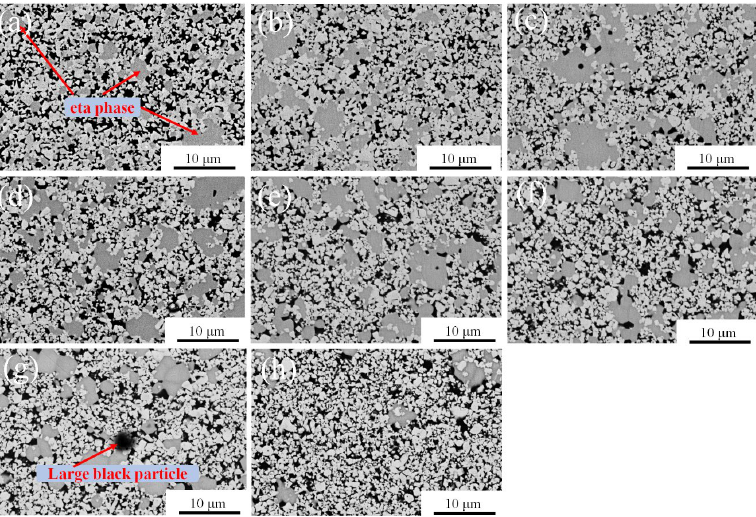
Figure 5. BSE-SEM microstructure of alloys, ( a ) 0Mo-5.13C, ( b ) 1Mo-5.07C, ( c ) 2Mo-5.01C, ( d ) 2.5Mo- 5.0C, ( e ) 2.5Mo-5.3C, ( f ) 2.5Mo-5.45C, ( g ) 2.5Mo-5.75C, ( h ) 2.5Mo-6.1C. ( e ) 2.5Mo-5.3C, ( f ) 2.5Mo-5.45C, ( g ) 2.5Mo-5.75C, ( h ) 2.5Mo-6.1C.